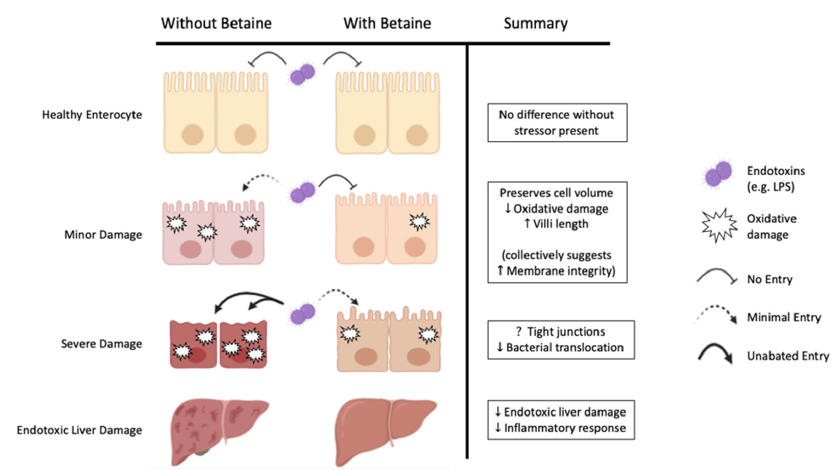
Figure 2. Betaine’s potential role in minimizing gut permeability through the preservation of enterocyte integrity and function during increasing severities of damage, as evidenced by data from cell culture and animal